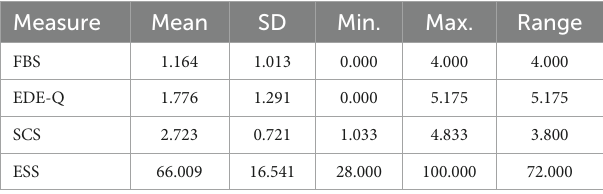
TABLE 1 Descriptive statistics for study measures.